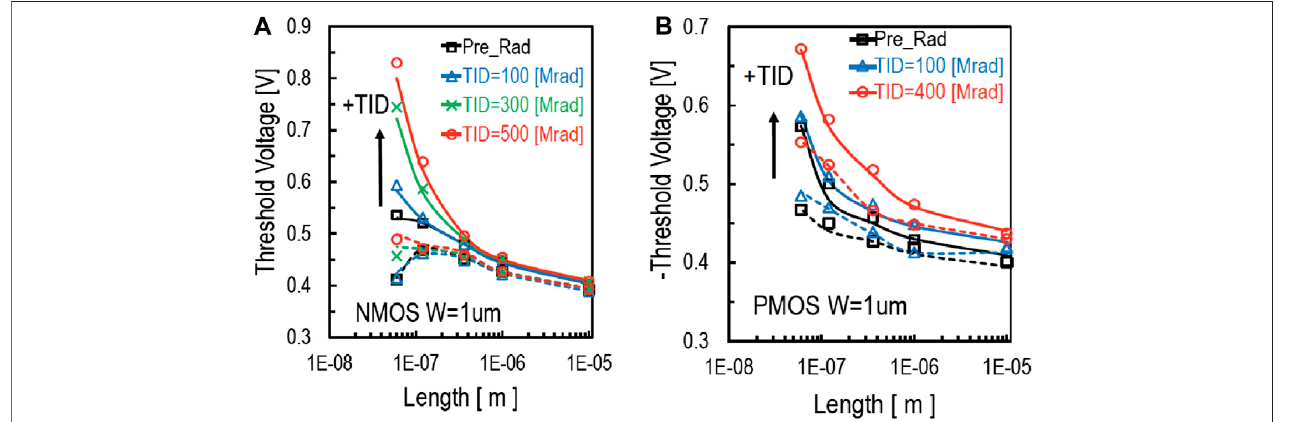
FIGURE5| SchematicrepresentationoftheMPA-SSAconcept,withtwolayerssiliconsensoridentifyinganincidentparticle.Twohitsidentifyaparticle,thesmaller the curvature of the trajectory, the largest the transverse momentum: this allows to quickly select high-pt L1 by correlating the position of the two hits (A) . Schematics of digital logic are shown on (B) From [8].